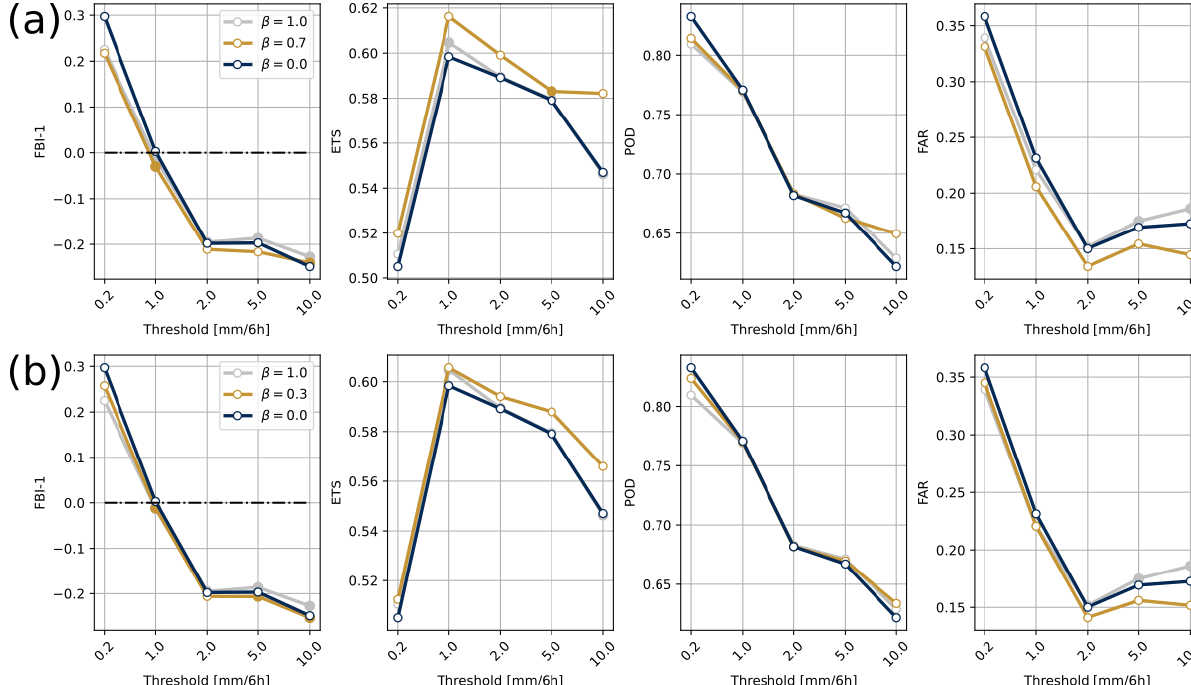
Figure 4. Same as Fig. 3 but for the winter experiment with β = 0 . 7 (a) , β = 0 . 3 (b) , and β = 1 . 0 ( a , b ), with all three compared to the reference experiment ( β = 0 .